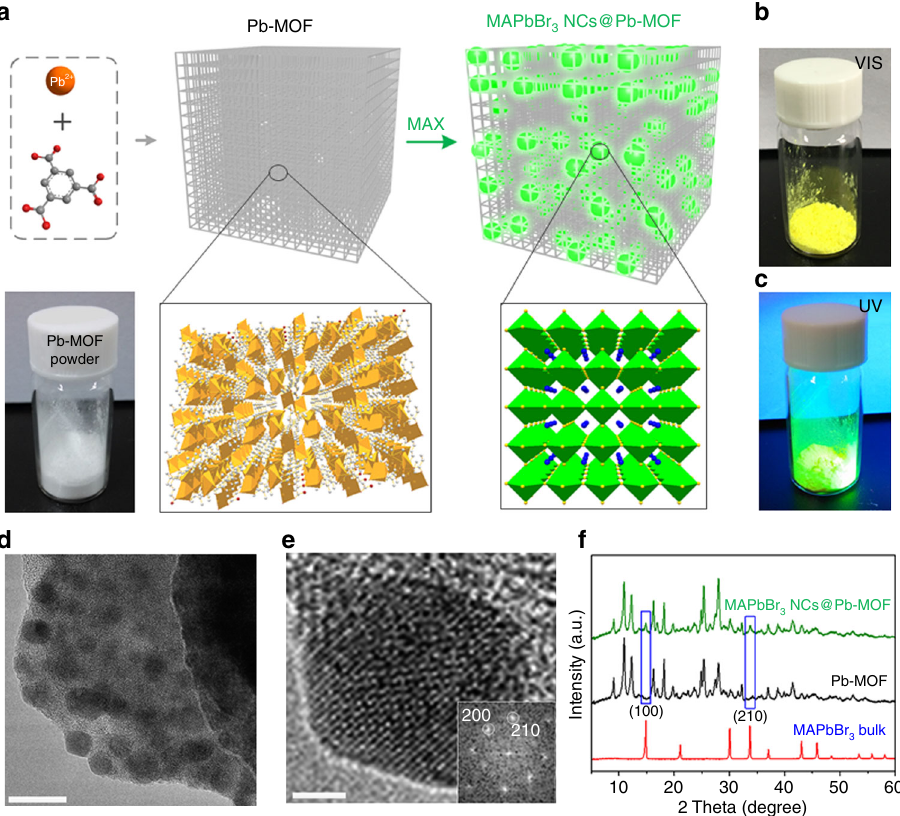
Fig. 1 Conversion of a Pb-MOF to luminescent MAPbBr 3 NCs@Pb-MOF. a Schematic of the conversion process. MAX represents the halide salt (CH 3 NH 3 X, X = Cl, Br, or I). The green spheres in the matrix represent the MAPbBr 3 NCs. The two black boxes show 3D crystal structure of the Pb-MOF (left) and MAPbBr 3 (right). The Pb coordination polyhedra of the Pb-MOF (the Pb atom are coordinated by nine O atoms, in which two O atoms of one carboxylate coordinate to a Pb and also bridge two adjacent Pb atoms) and MAPbBr 3 are represented in orange and green, respectively. Other atom color scheme: C = gray, O = red, N = blue, Br = yellow. H-atoms have been omitted for clarity. b , c Optical images of MAPbBr 3 NCs@Pb-MOF powder under b ambient light and c 365 nm UV lamp; d – f Characterization of the MAPbBr 3 NCs@Pb-MOF: d TEM image, e HR-TEM image of one individual NC with the corresponding fast Fourier transformation image in the bottom right corner and f XRD patterns. Scale bar, 20 nm ( d ); 5 nm ( e